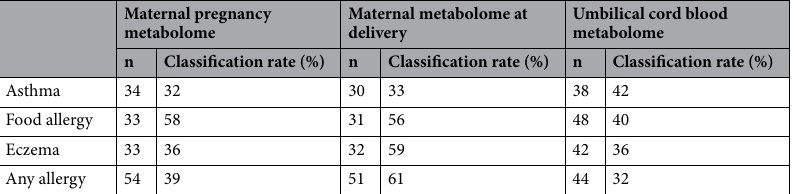
Table 4. Associations of allergic outcomes with the mothers’ plasma metabolomes during the third trimester and delivery and from the umbilical cord at birth for matched case/control pairs. Results presented as the proportion of correctly classified samples as healthy or allergic using random forest multilevel modelling based on matched case–control pairs.